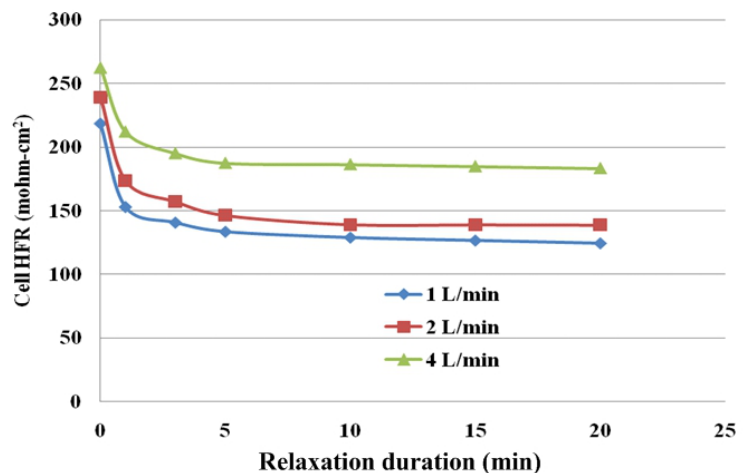
Figure 15. HFR variations after gas